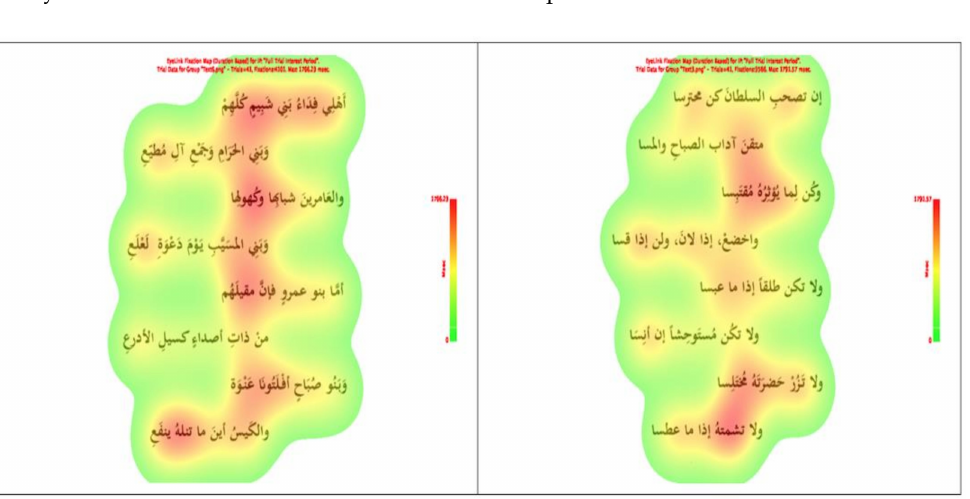
Figure 3. Examples of heatmaps built from two texts by averaging the fixations of all participants when looking at the two texts. The text on the right is a text, which is a poem written in the Andalusian era, with a higher readability score than the text on the left, which is a poem written in the pre-Islamic